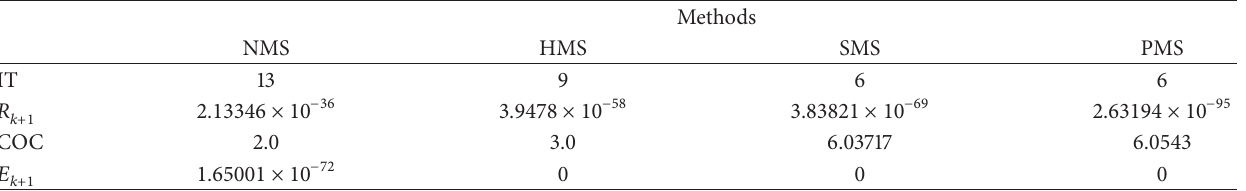
Table 2: Results of comparisons in Example 2 for the matrix sign.